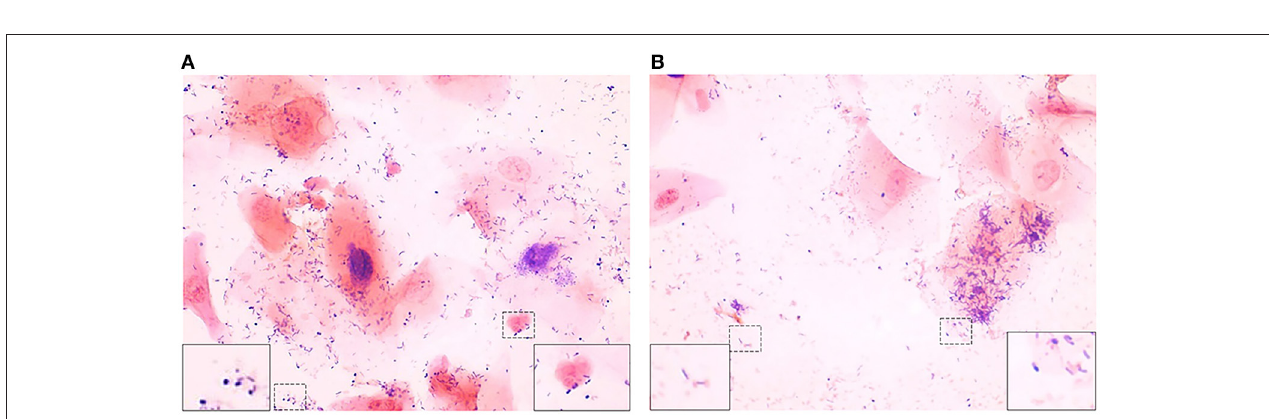
FIGURE 1 | Sheep inflammatory and epithelial cells. (A) Inflammatory cells can be seen in this Gram-stained slide as small cells with large or multi-lobulated nuclei. The epithelial cells were seen as (B) mature, which are the superficial cells with small nuclei and large cytoplasm, as (C) intermediate, which have less cytoplasm and slightly larger nuclei, and as (D) , parabasal, which are near the basal or deepest cell layer and that have large nuclei and small amount of cytoplasm (micrographs are × 100 oil immersion).